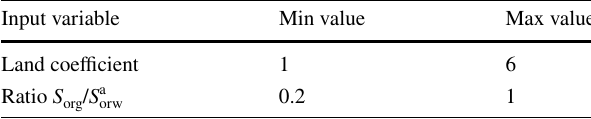
Table 4 Relative permeability input